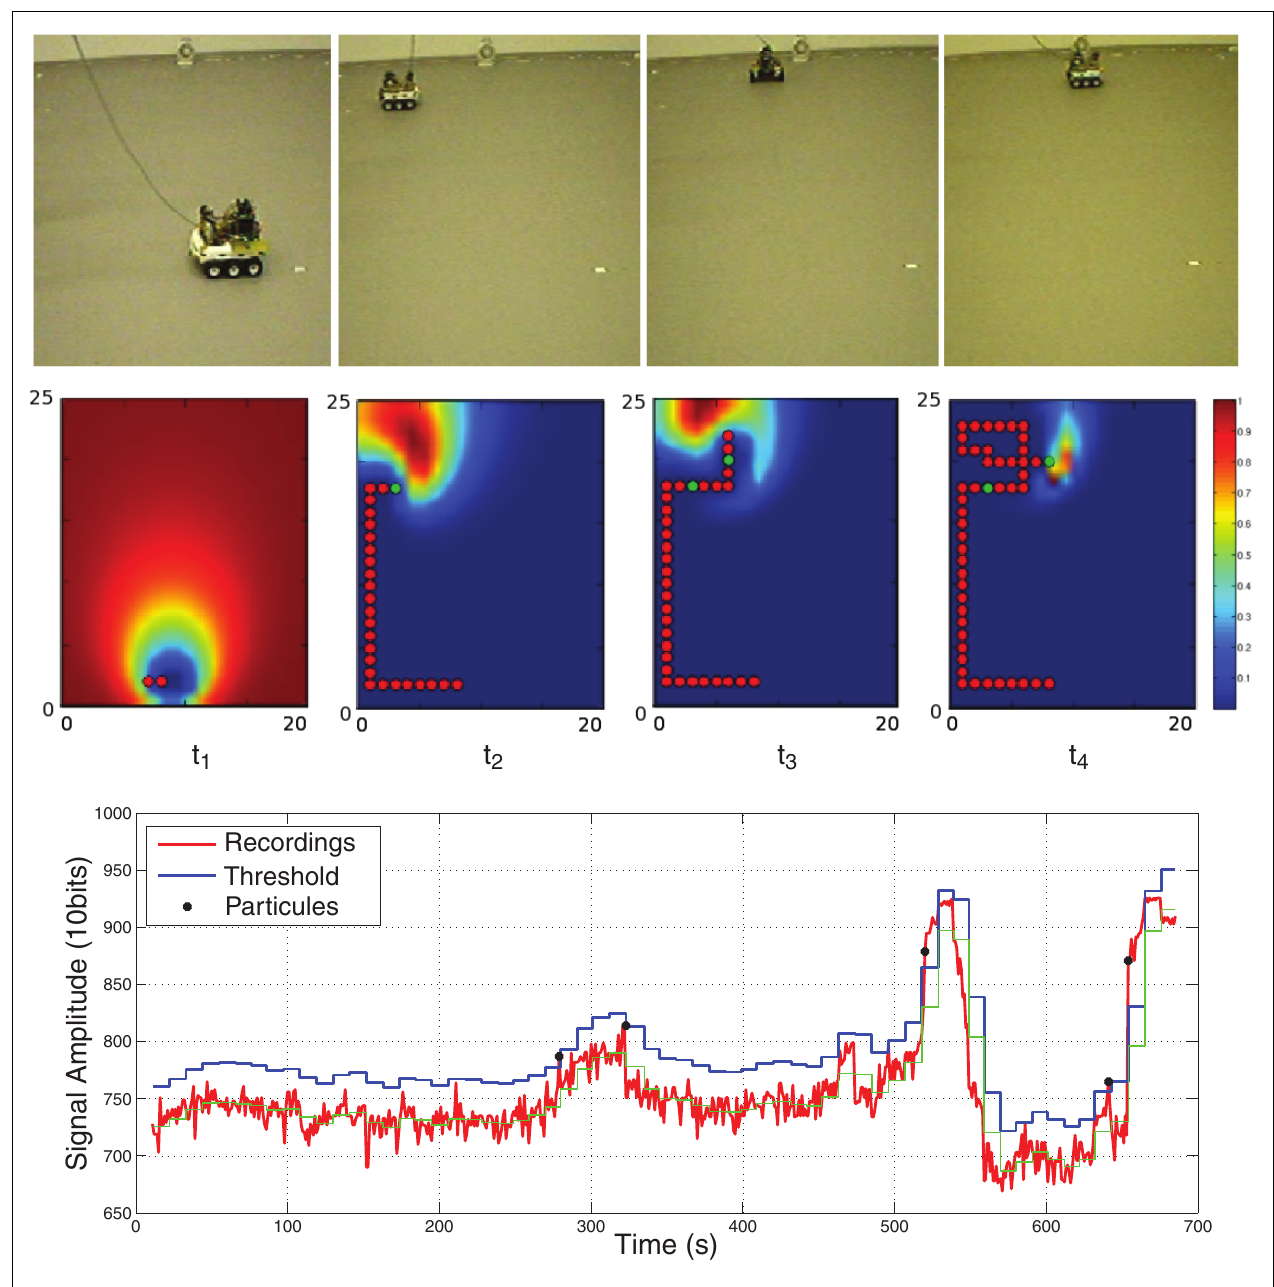
indicating a detection. Wind blows downwards. The source is at location (9,24), the robot starting point is (10,2). Bottom: Detection procedure. The sensor signal, recorded at 10 Hz during the robot path, is shown in red. An adaptive detection threshold, in blue, is derived from the smoothing average, in green. The fi ve detected patches are indicated as black